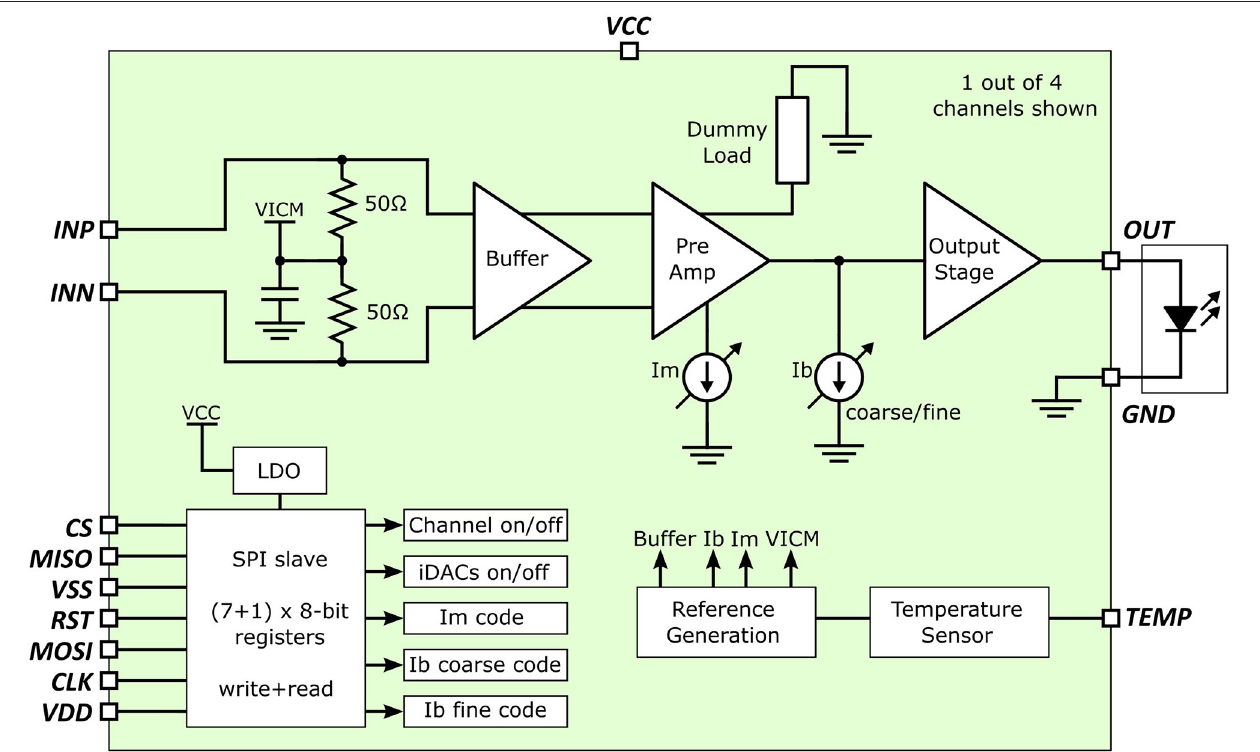
FIGURE 9 | VCSEL driver block